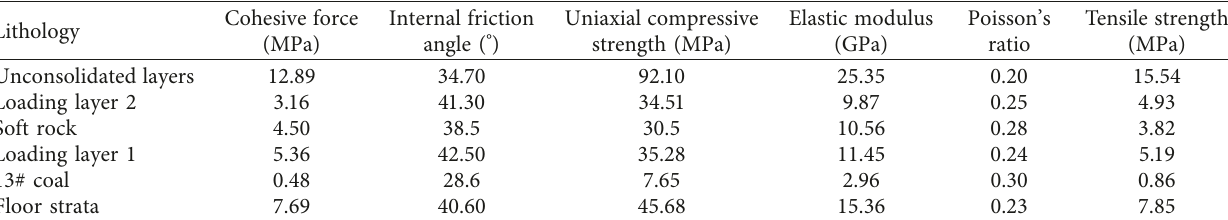
Figure 2: Numerical calculation model diagram: (a) single bearing stratum and (b) double bearing strata. Table 1: Mechanical properties of coal and